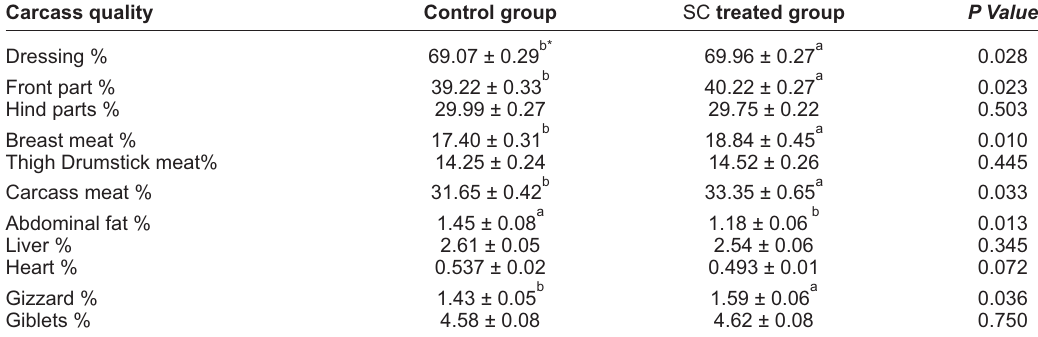
Table-3: Effect of the SC on carcass characteristics of broiler chickens Carcass